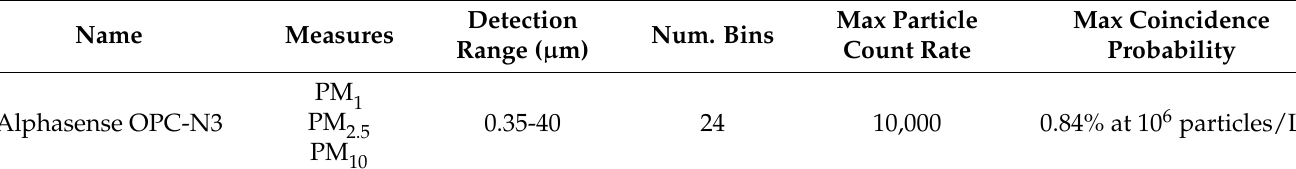
Figure 4. Photo of deployed sensor casing, including gas and particulate matter sensors, controller and power boards, and respective legend. Table 1. Technical specifications of Alphasense OPC-N3 particle monitor, as specified by the manufacturer